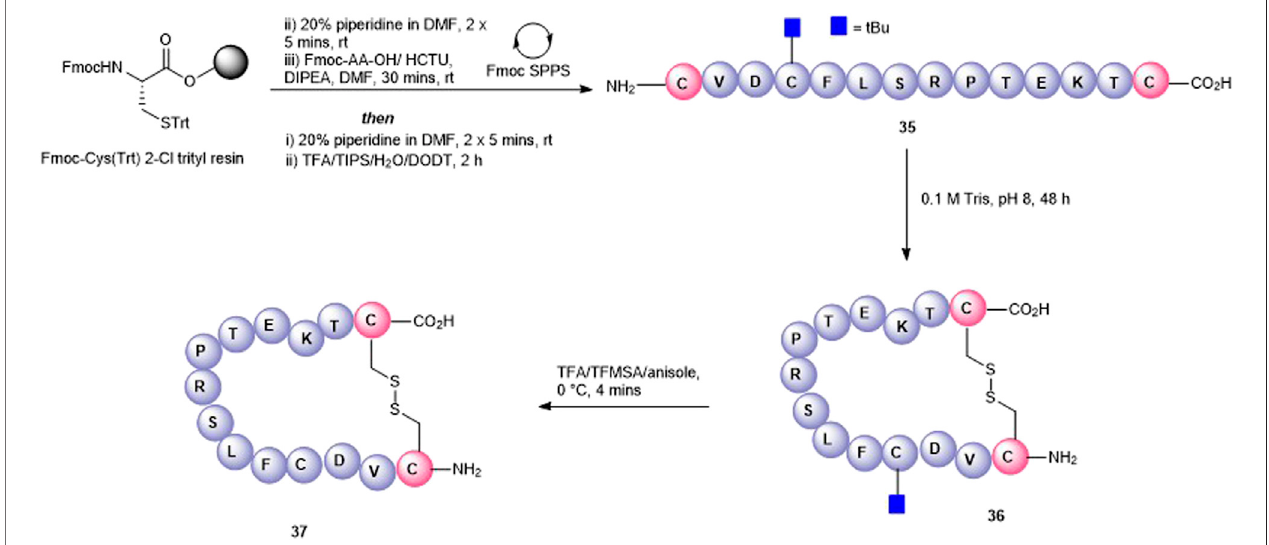
FIGURE 8 | Synthesis of a disul fi de-linked head-to-tail macrocycle 37 via introduction of Cys at the C- and N -termini.